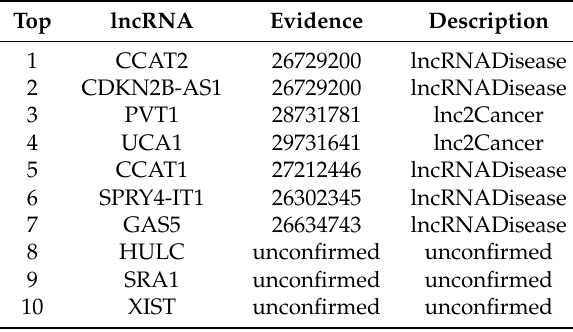
Table 2. The top ten lncRNA candidates for lung